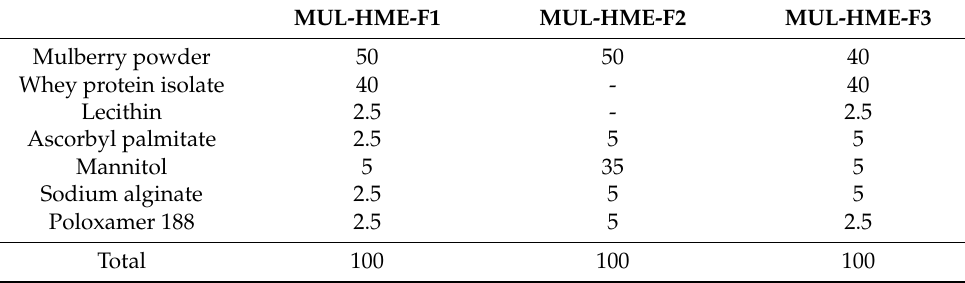
Table 1. Formulation ratio of mulberry and biopolymers